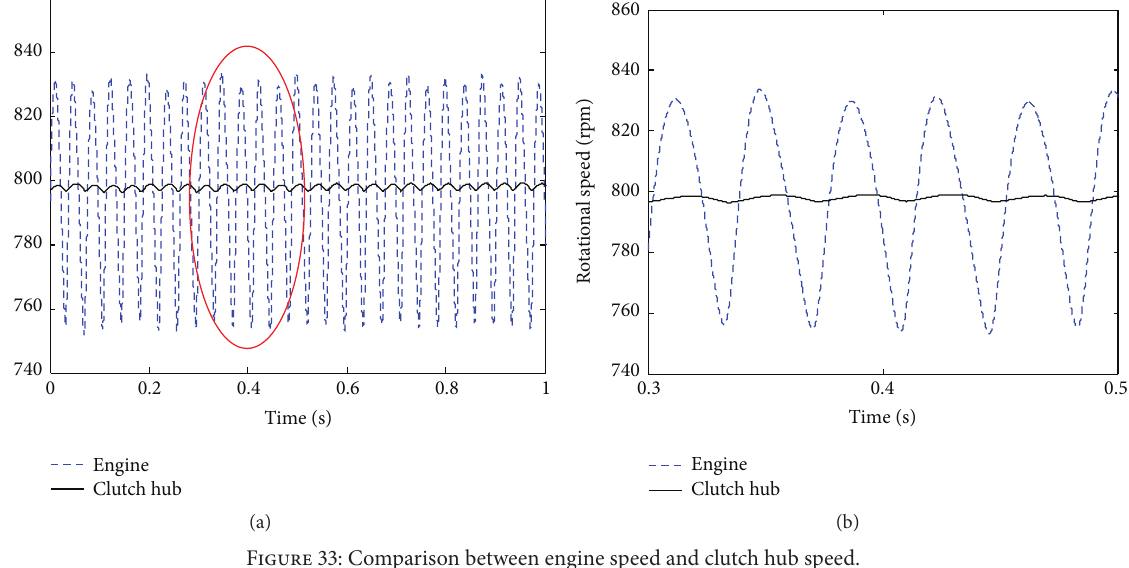
Figure 33: Comparison between engine speed and clutch hub speed.